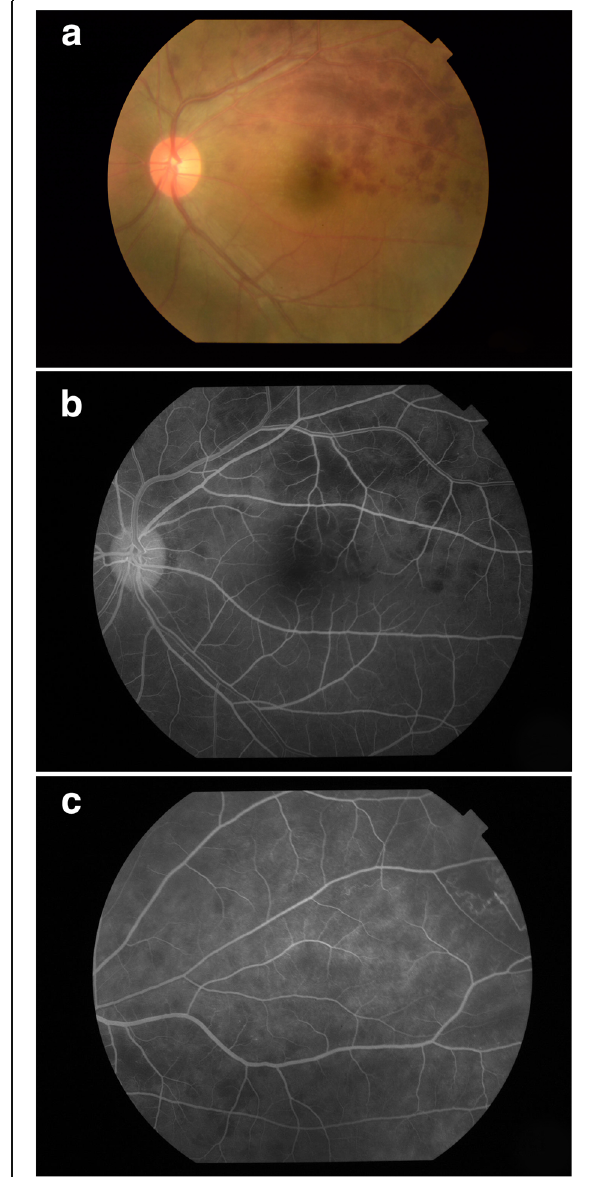
Fig. 2 a Fundus photo from patient 3 showing evidence of obliterative, necrotising retinal vasculitis causing branch retinal artery occlusion with retinal haemorrhages during active ocular Behcet ’ s relapse. b Fluorescein angiography of the same patient showing evidence of vasculitis and non-perfused area. c shows an area of retinal ischaemia in the same patient with development of neovascularization of the